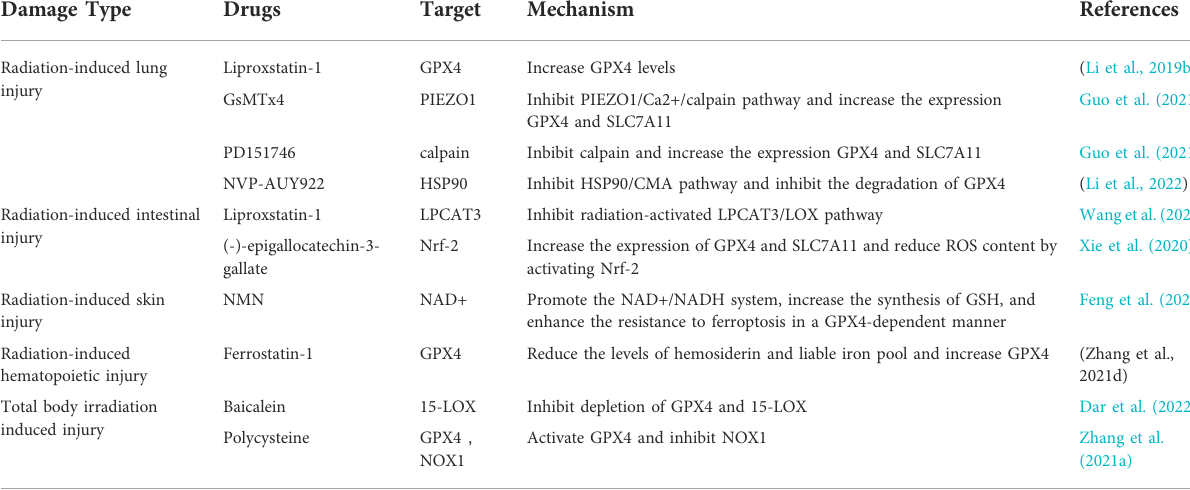
TABLE 2 Targets and mechanisms of ferroptosis inhibitors alleviating radiation injury.